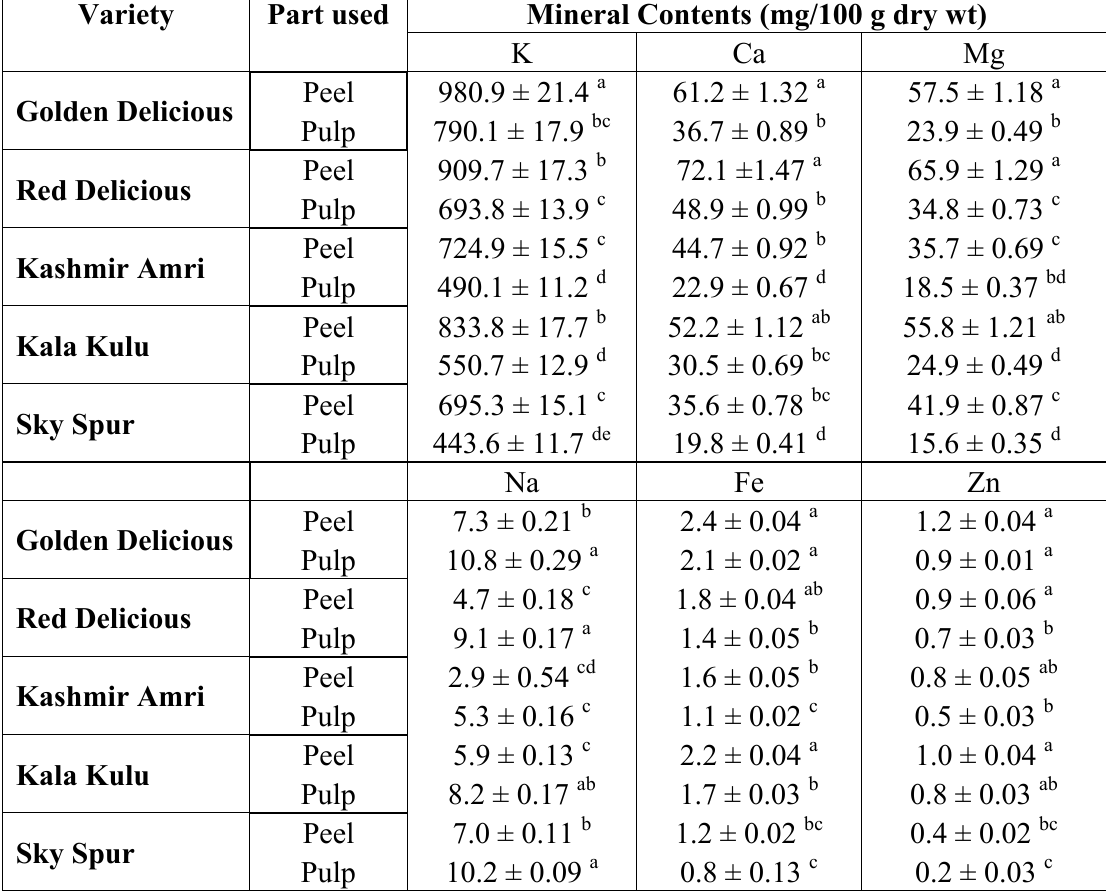
Table 3. Mineral content in peel and pulp tissues of different cultivars of apple ( Malus domestica Borkh.)